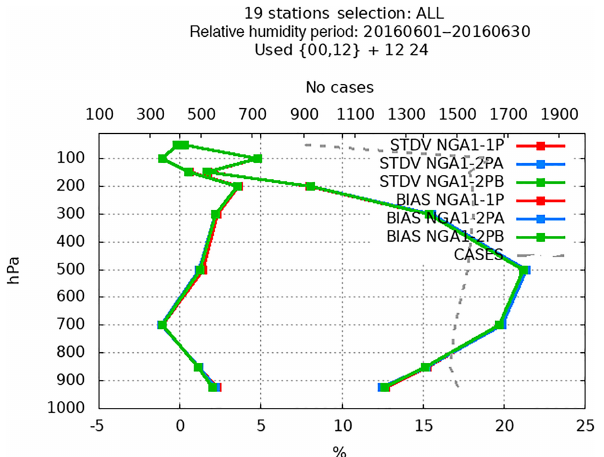
Figure 8. Bias and standard deviation of + 12 and + 24h relative humidity (unit: %) forecasts as a function of vertical level for verifi- cation against radiosonde observations. Scores are for experiments B1 (red), B2 (blue) and B3